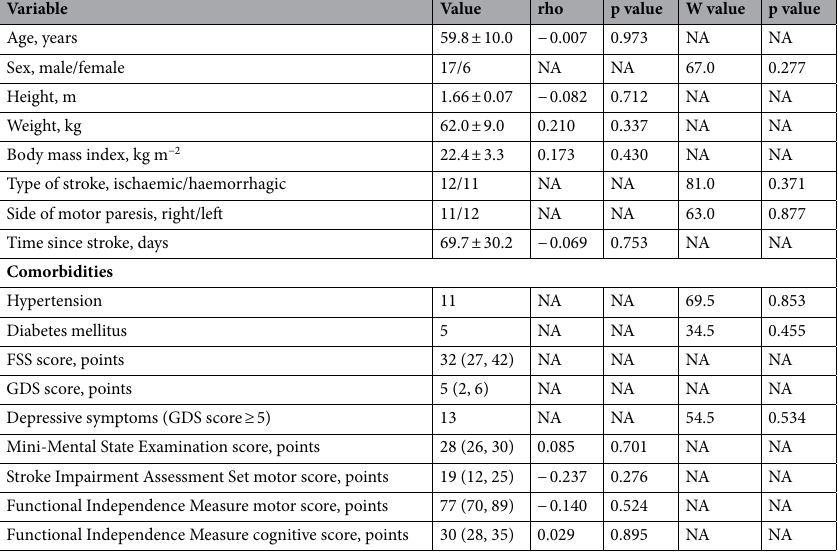
Table 1. Associations between the Fatigue Severity Scale score and participants’ characteristics. Values are presented as mean ± standard deviation, median (interquartile range), or number. rho Spearman’s rank correlation coefficient, FSS Fatigue Severity Scale, GDS Geriatric Depression Scale, NA not